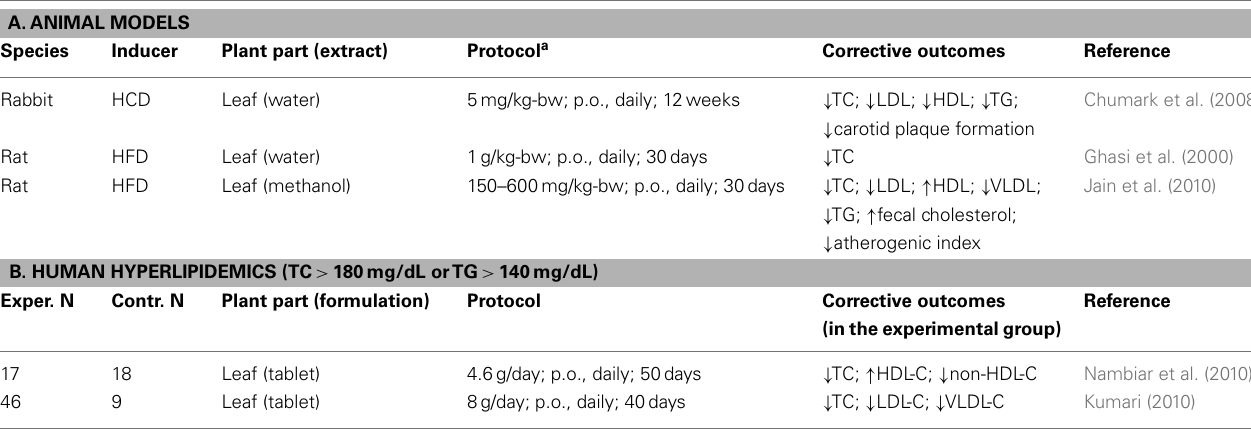
Table 2 | Moringa oleifera experimental therapy for chronic